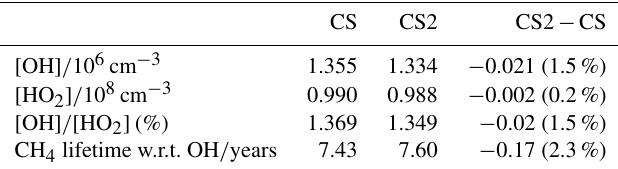
Table 7. Tropospheric average HO x parameters for CS and CS2.